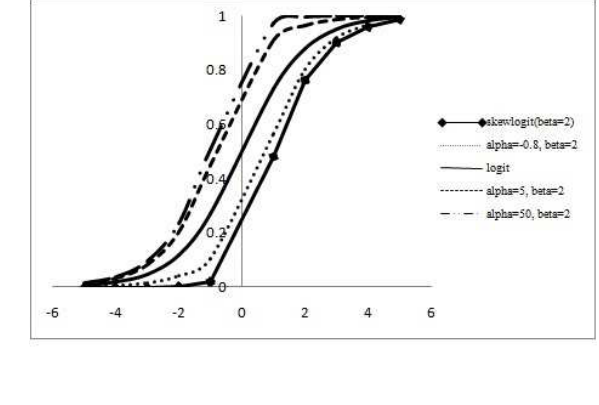
Figure 1 – Plots of regression function of MSLD ( α, 2) for different values of α .